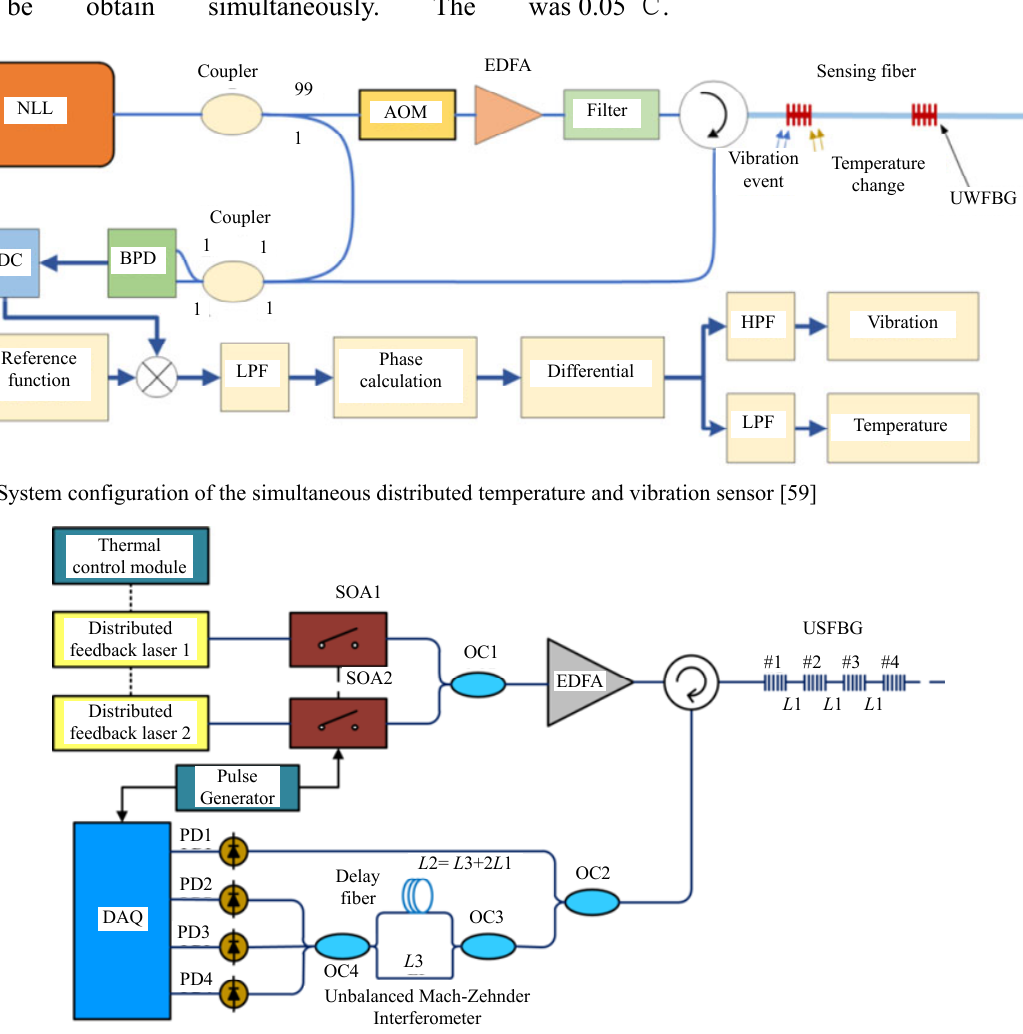
Fig. 17 Schematic diagram of the distributed optical static and dynamic sensing system